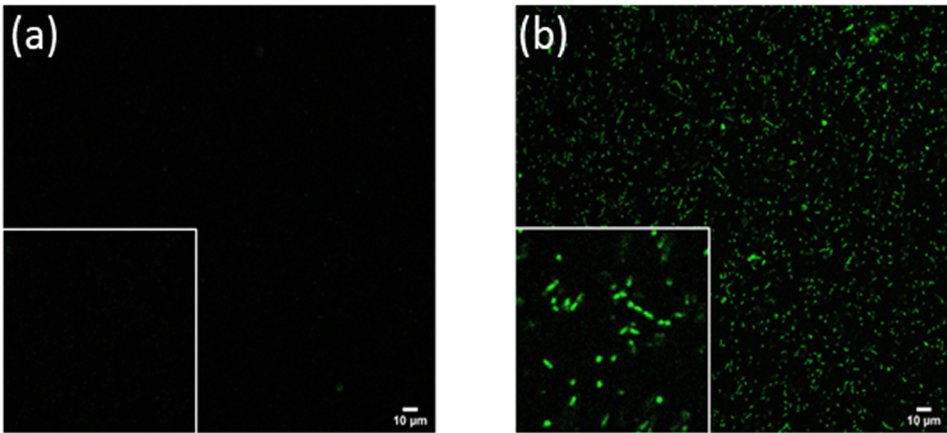
Figure 1. Confocal fluorescence microscopy of juice encapsulated cells with a 405 nm excitation, and 500–550 nm emission; ( a ) L. casei control cells; ( b ) L. casei cells encapsulated with MG juice. Lower left is the zoomed-in view of the same image: zoomed-in views in ( b ) demonstrated the uniform intracellular localization of polyphenolic compounds in the cell carriers.